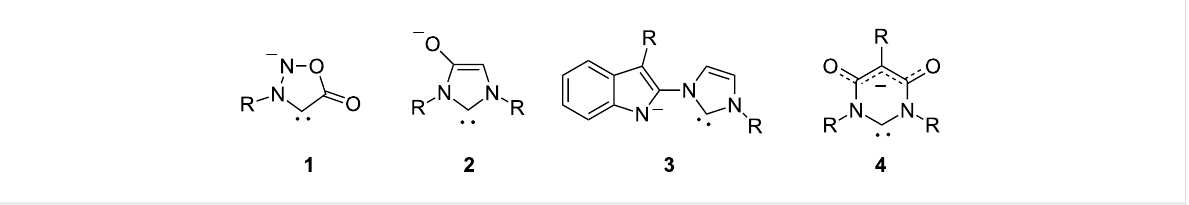
Figure 1: Examples of anionic N-heterocyclic